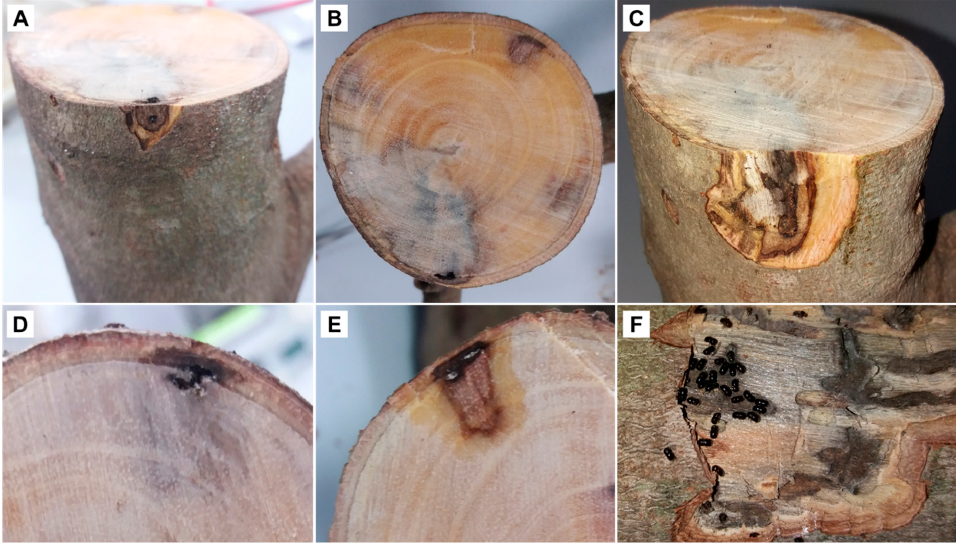
Figure 2 . Carob tree branches infested by Xylosandrus compactus . Necrotic tissue below the entry hole ( A ); gallery in cross section ( B ); gallery in longitudinal section ( C ); different shapes of galleries in cross section ( D , E ) and in longitudinal section ( F ).